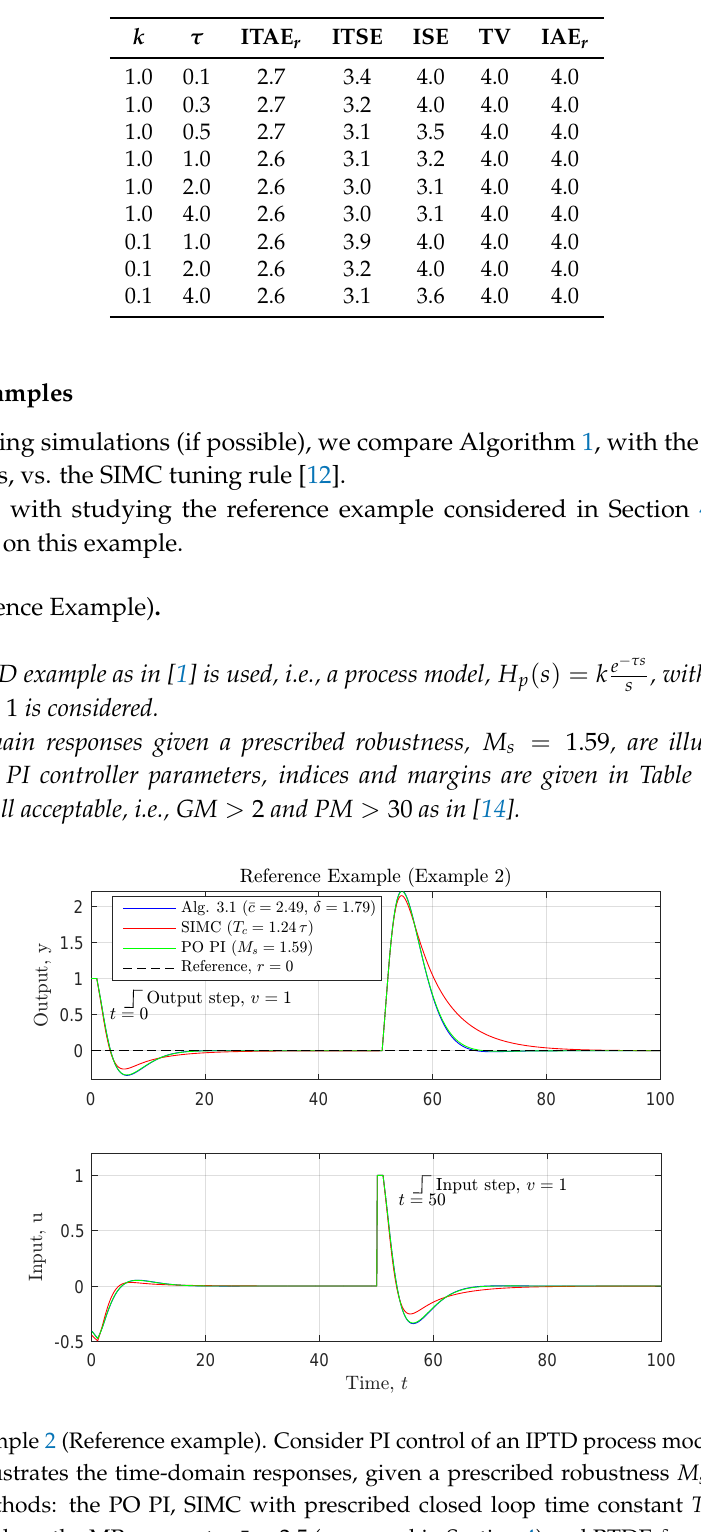
Algorithm 1 where the MP parameter ¯ c = 2.5 (proposed in Section 4) and RTDE δ = 1.79. An output disturbance unit step is presented at time t = 0 and an input disturbance unit step at time t =